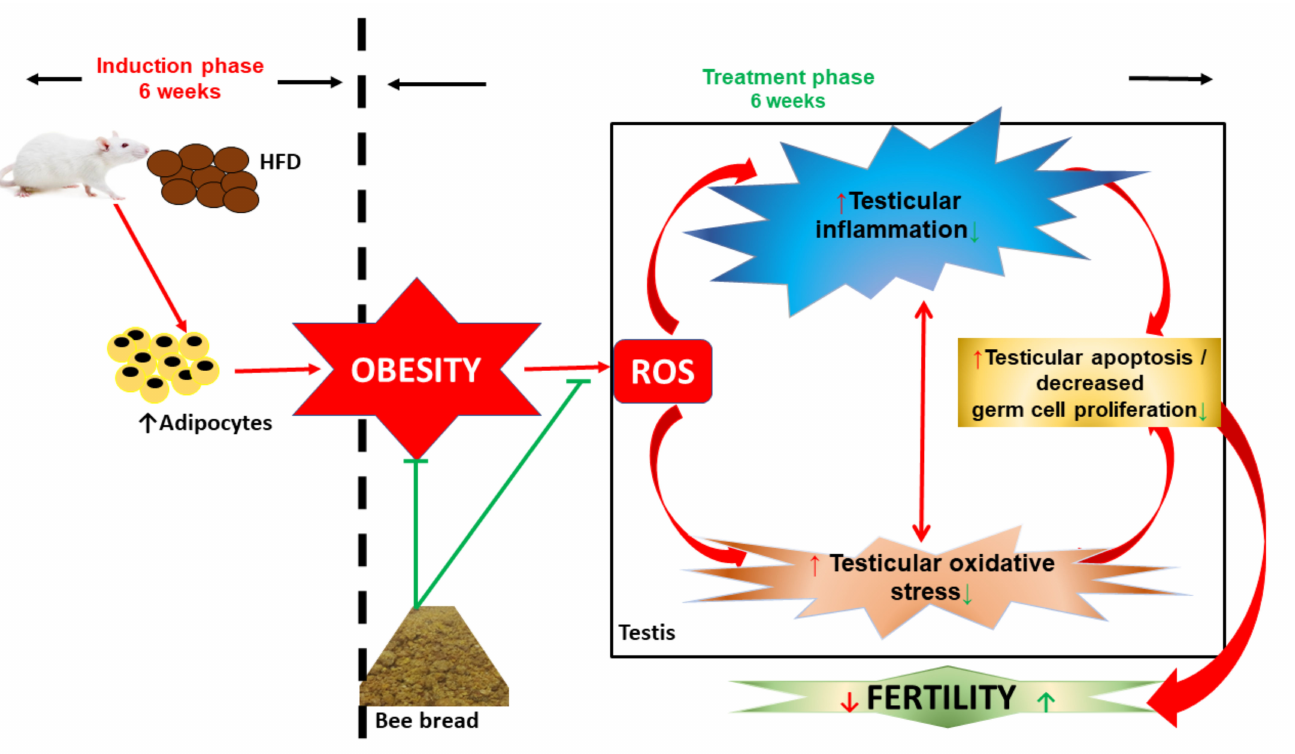
Figure 7. Schematic representation of therapeutic effects of bee bread on testicular-derived oxidative stress, inflammation, and apoptosis. HFD: high-fat diet, ROS reactive oxygen